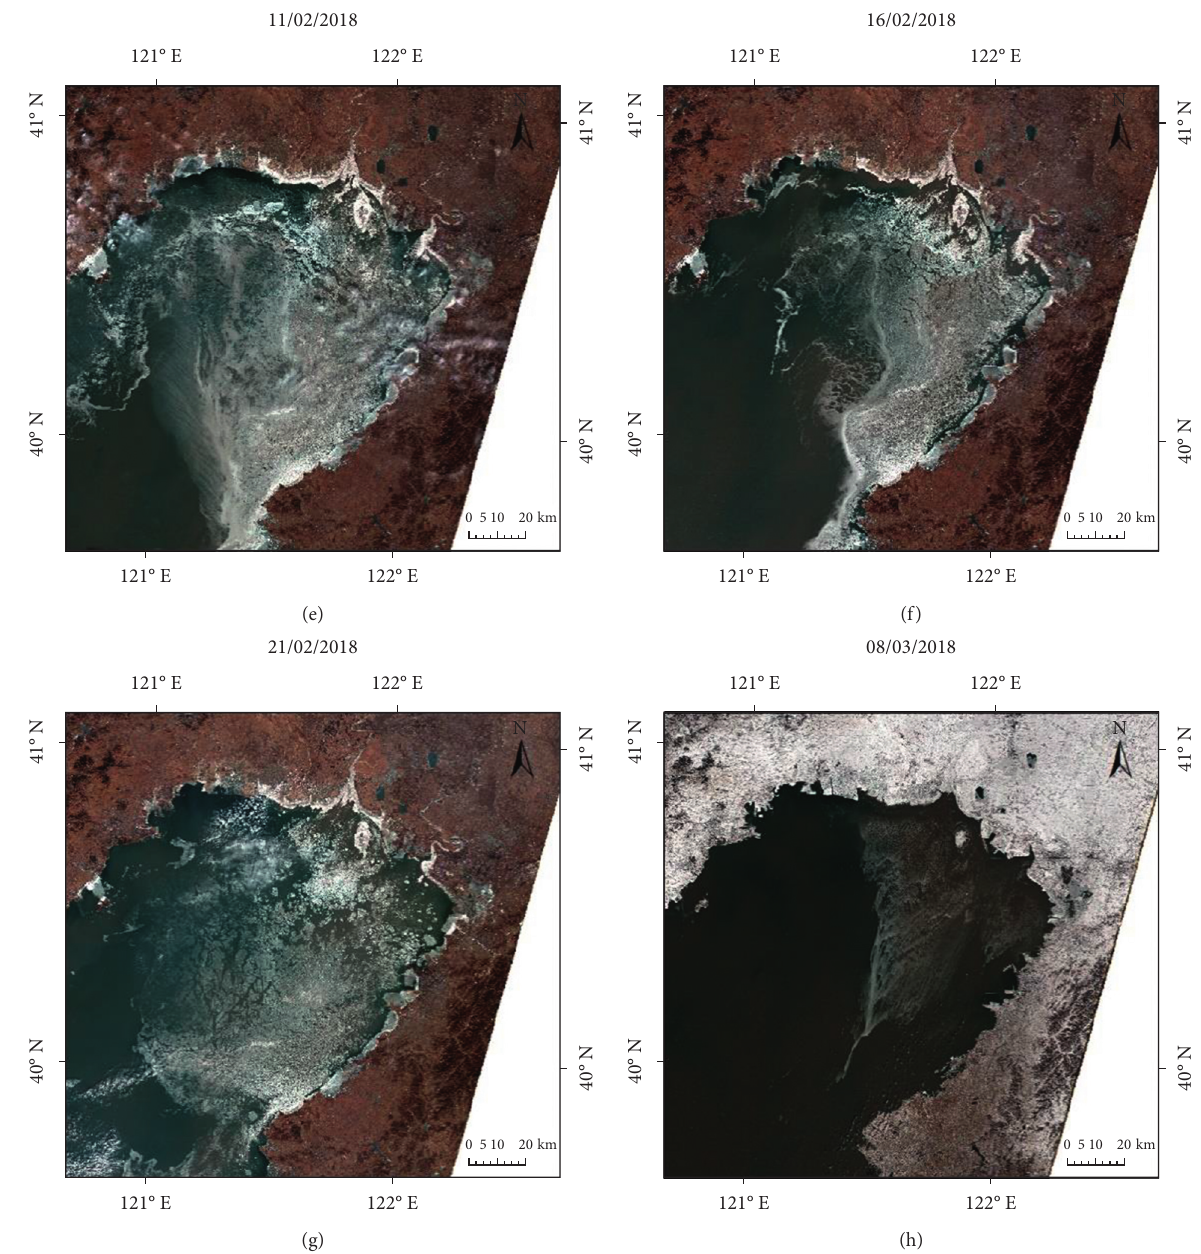
Figure 4: The true color images composited by bands 4, 3, and 2 after preprocessing. (a–h) The true color images in Liaodong Bay on (a) 02/ 01/2018, (b) 12/01/2018, (c) 27/01/2018, (d) 01/02/2018, (e) 11/02/2018, (f) 16/02/2018, (g) 21/02/2018, and (h) 08/03/2018. The snowfall occurred in Liaodong Bay from 15: 00 on 7 March to 2:00 on 8 March 2018. As a result, the color of images acquired on 8 March 2018 is different from the other 7